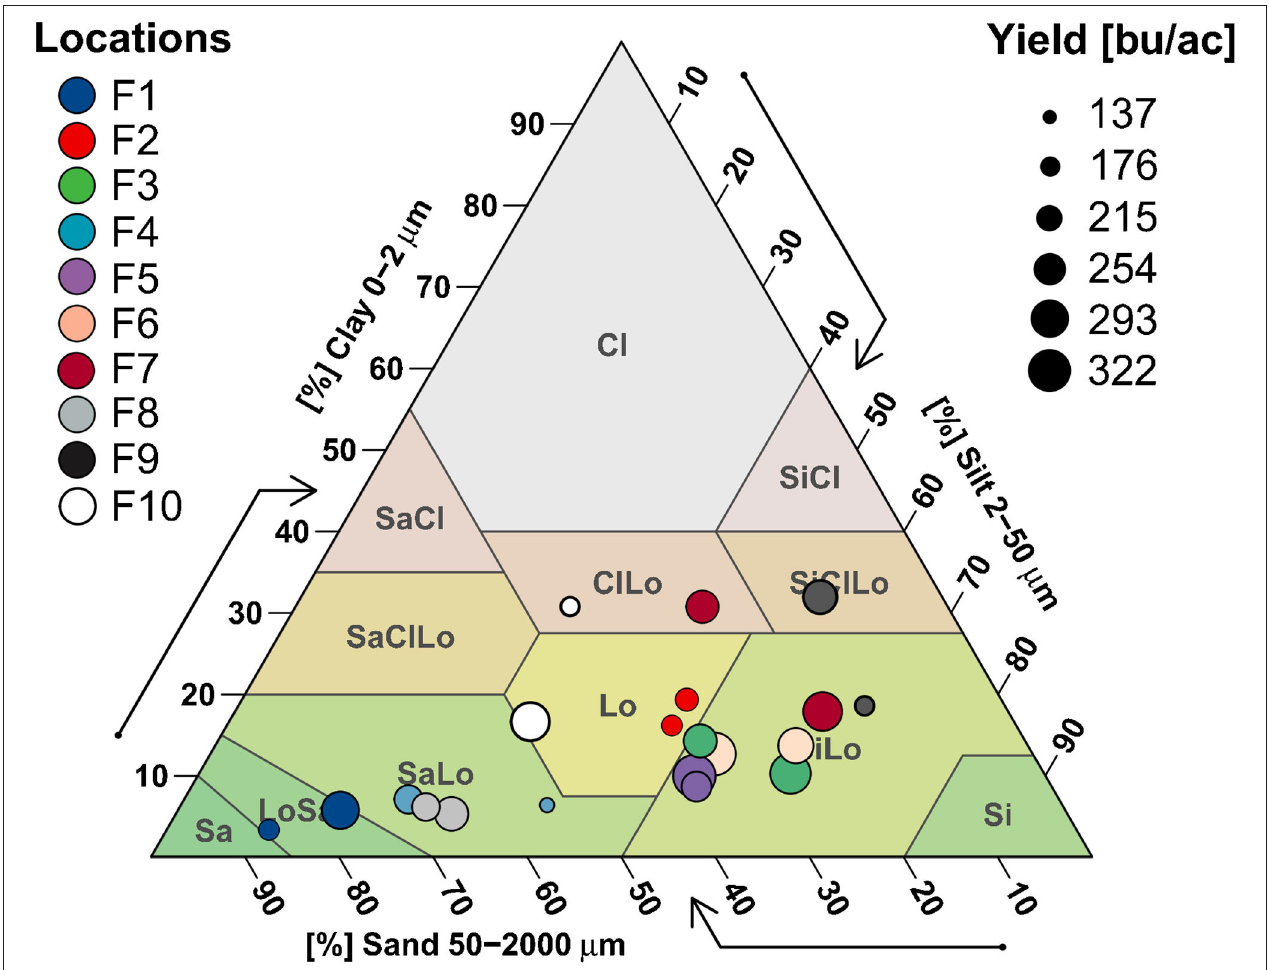
FIGURE 4 | Average soil texture values are mapped onto a USDA Texture Triangle to visualize patterns of soil textural class in relation to farm and